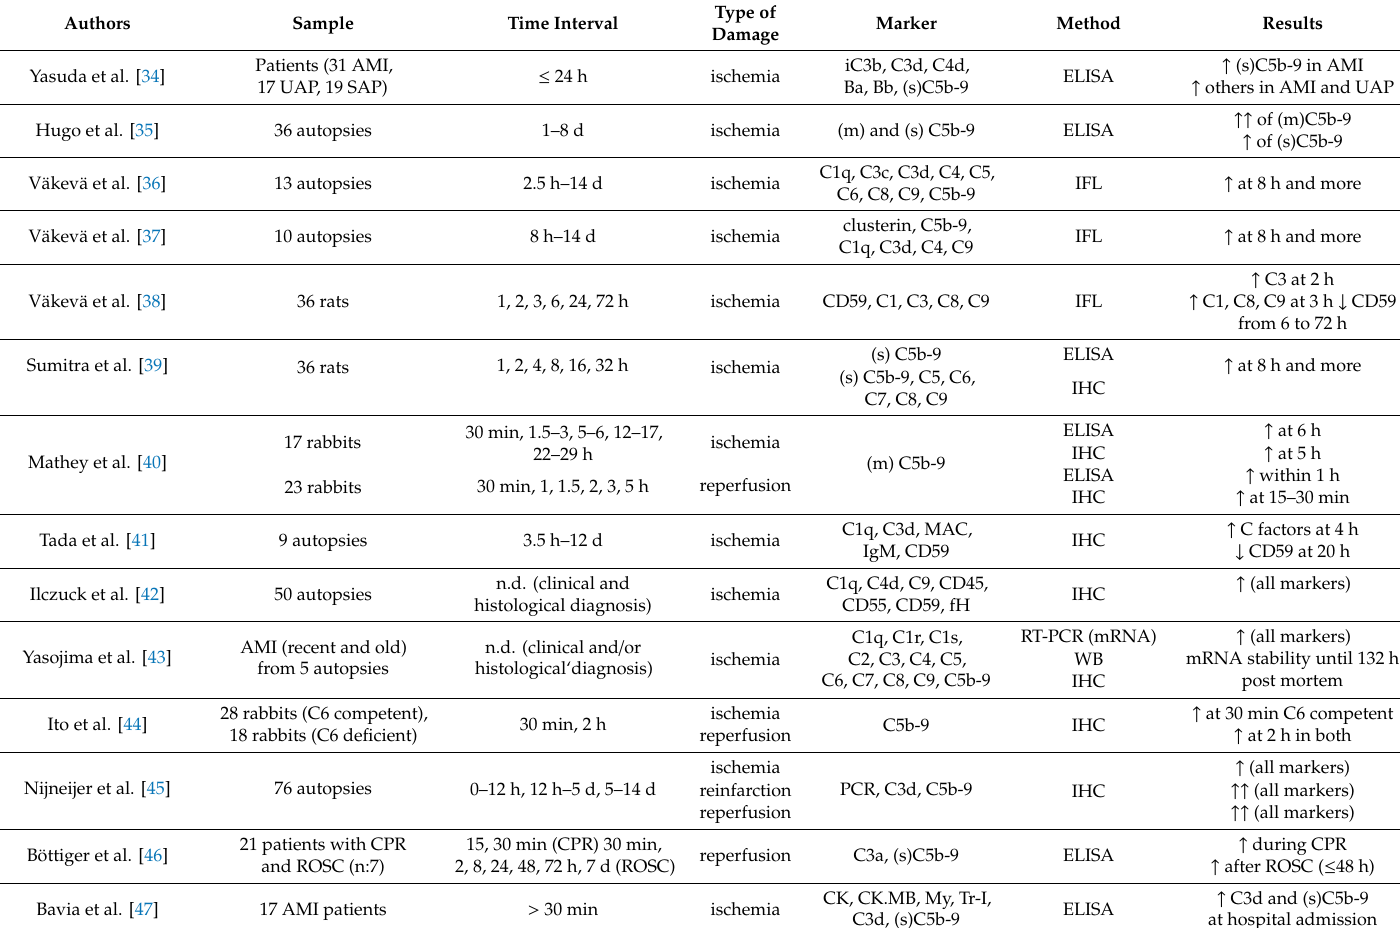
Table 1. Summary of the main data resulting from analyzed pathophysiological / clinical